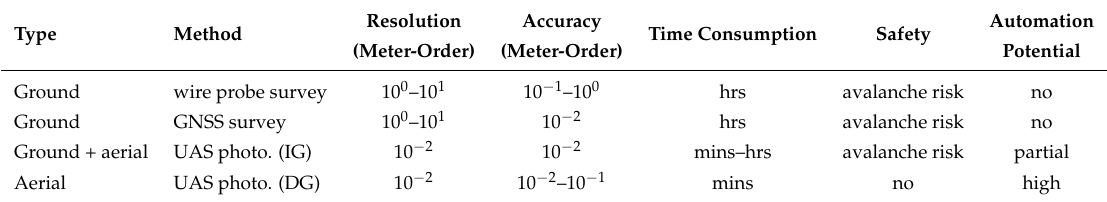
Table 5. A comparison of the snow-field mapping